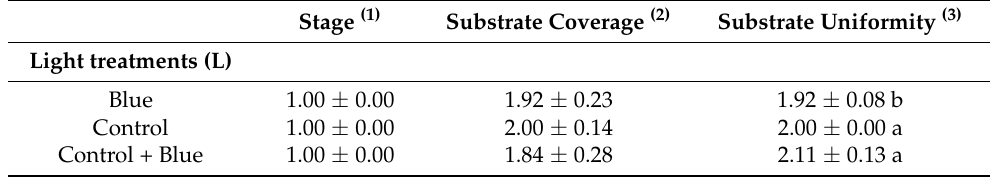
Table 1. Seedling stage, substrate coverage, and uniformity at the time of harvest of two brassica microgreens (Broccolo Natalino and Mugnoli) cultivated in a growth chamber under three different light spectra: Blue (B), Control (CTRL), and Control + Blue (CTRL + B). Means followed by different letters within a column indicate significant differences according to Student–Newman–Keuls (SNK) test at p =